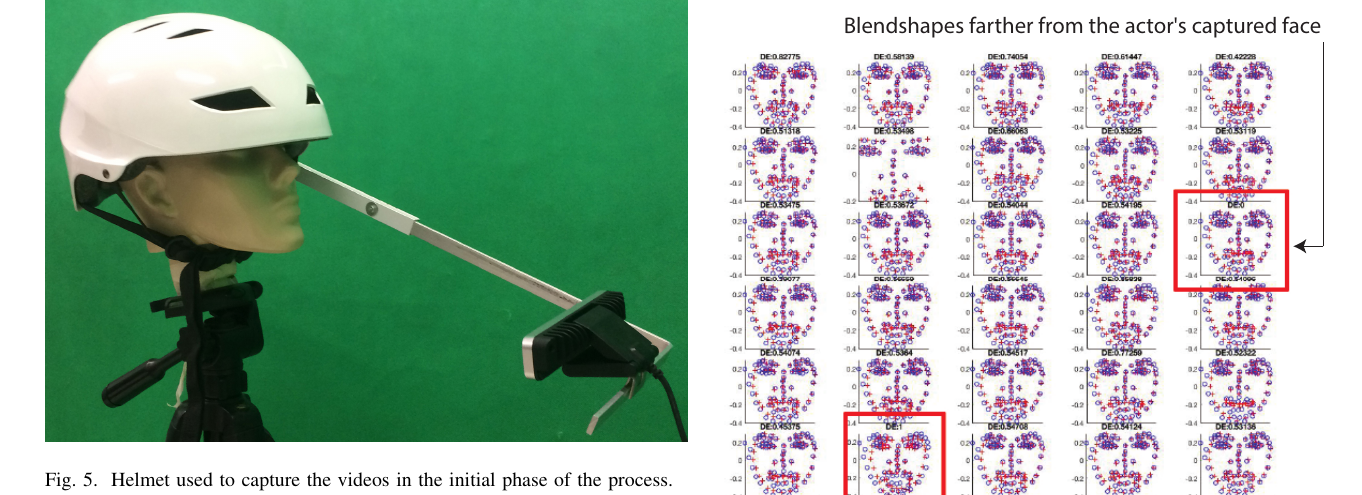
Fig. 5. Helmet used to capture the videos in the initial phase of the process.